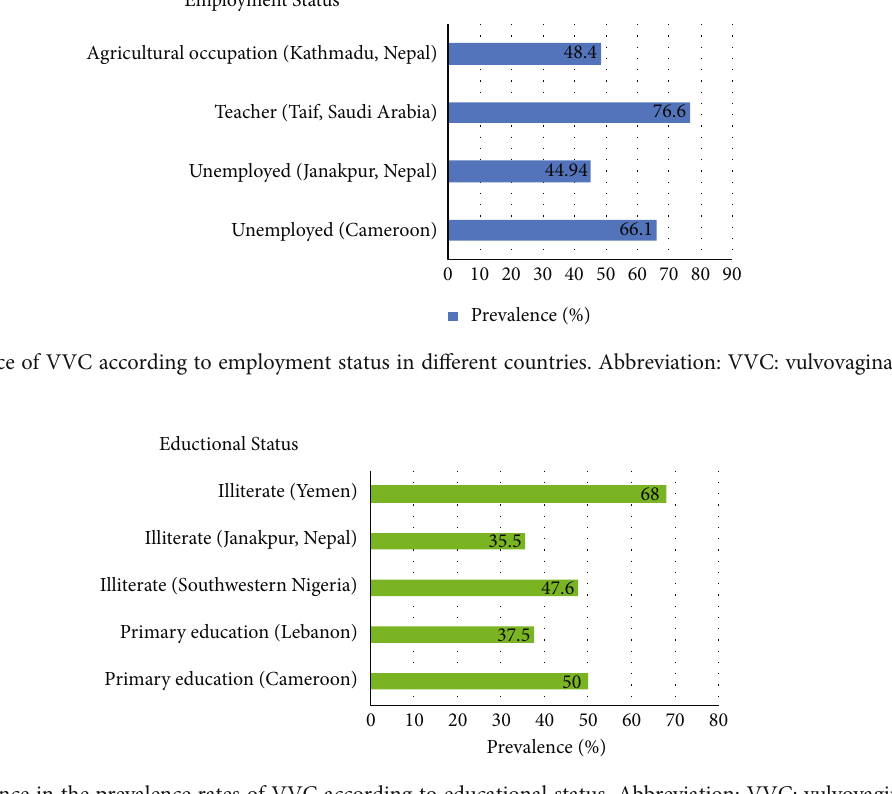
Figure 4: The di ff erence in the prevalence rates of VVC according to educational status. Abbreviation: VVC: vulvovaginal candidosis.